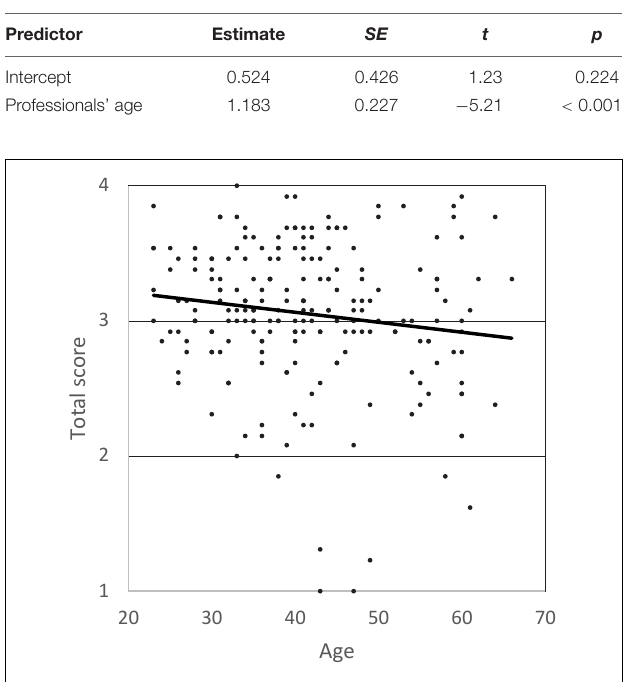
TABLE 6 | Linear regression model on total scores of the questionnaire for professionals.